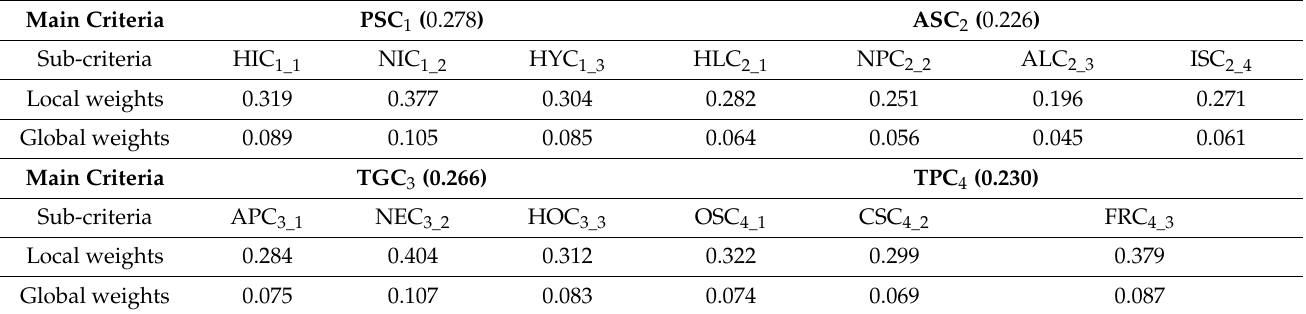
Table 10. The global weights of the sub criteria for evaluating intrusion-detection